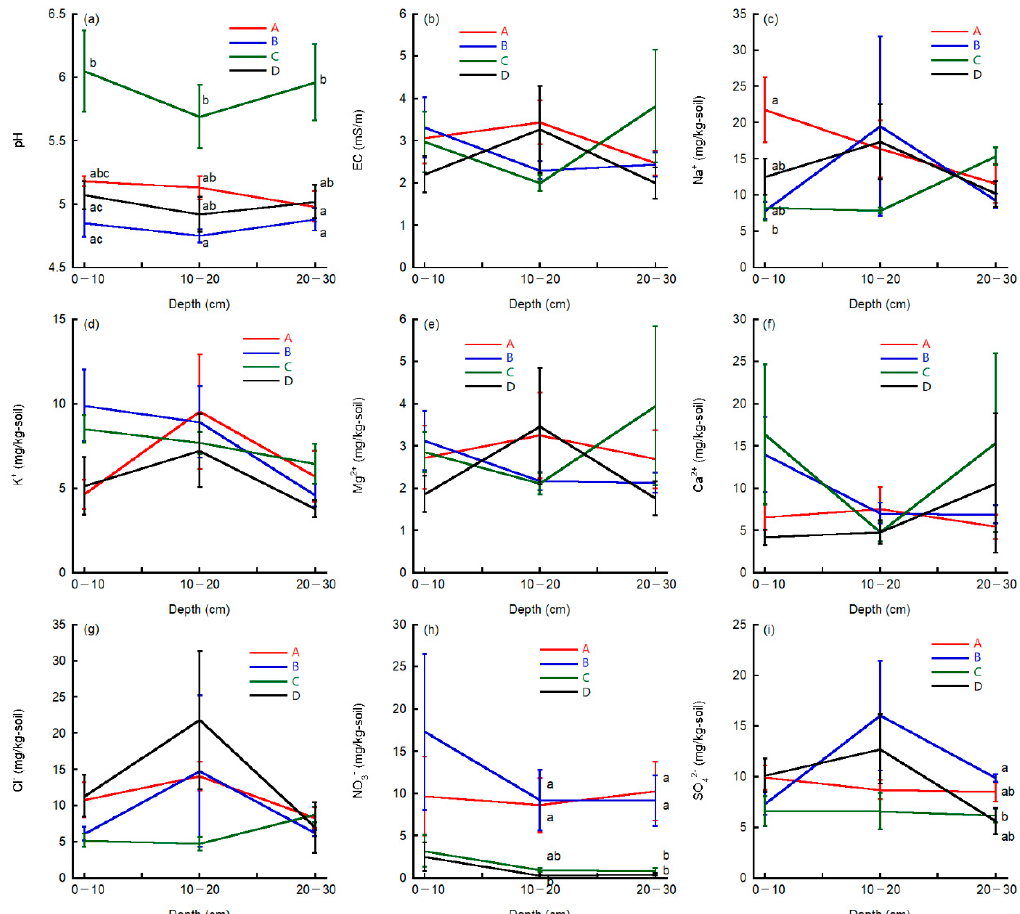
Figure 7. Chemistry of soil extracted water of samples in 0-10 cm, 10-20 cm, and 20-30 cm depths in each quadrat of the Sanri-Matsubara Forest, south-western Japan. ( a ) pH, ( b ) EC, ( c ) Na + , ( d ) K + , ( e ) Mg 2 + , ( f ) Ca 2 + , ( g ) Cl − , ( h ) NO 3 − , and ( i ) SO 42 − . Vertical bars denote SE. Significance of di ff erence between quadrats was tested by Kruskal-Wallis test and the following Mann–Whitney U-test with Bonferroni correction. Means sharing the same letter (a, b, c) were not significantly di ff erent ( p < 0.05) among each soil depth. Values without letters are not significantly different.